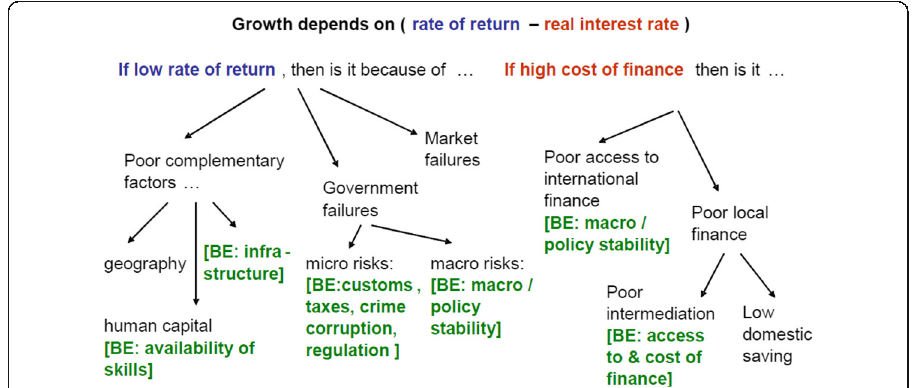
Fig. 1 Diagnosing the binding constrain in Kosovo through a decision tree. Source: Adapted from Carlin and Seabright